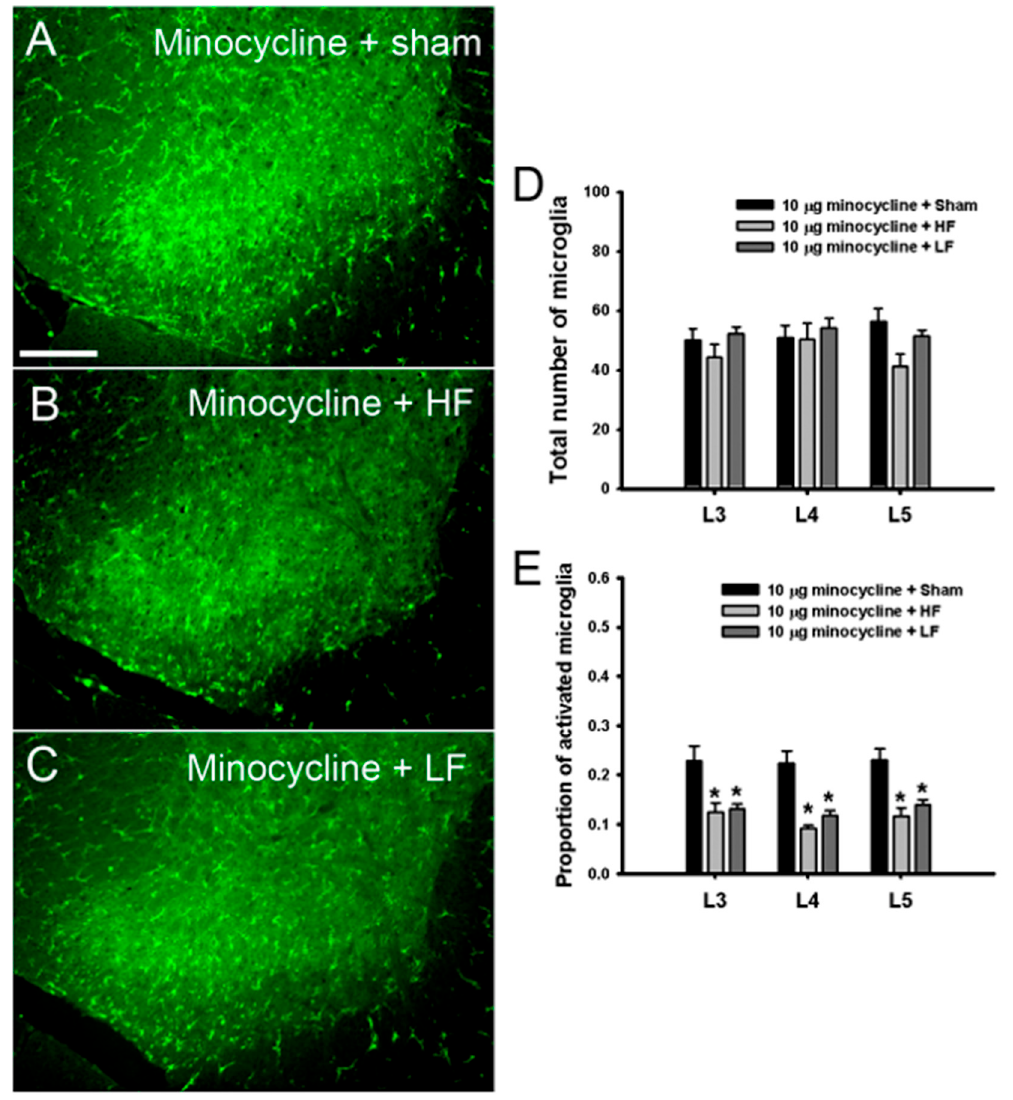
Figure 6. Changes in the expression of spinal microglia due to transcutaneous electric nerve stimulation (TENS) with minocycline (10 μ g) in TENS-tolerant rats ( A ) The expression of activated microglia was exhibited after sham TENS with minocycline. High-frequency (HF) TENS with minocycline ( B ) and low-frequency (LF) TENS with minocycline ( C ) changed the expression of microglia from the activated state to the resting state. ( D ) HF and LF TENS with minocycline treatments did not significantly change the total number of microglia expressed in the spinal segments compared with sham TENS with minocycline. ( E ) Compared with sham TENS with minocycline, both HF and LF TENS with minocycline treatment significantly decreased the proportion of activated microglia in the L3, L4, and L5 spinal segments. Asterisks (*) indicate values significantly different from that in the sham TENS with minocycline group. Scale bar: ( A – C ) 200 μ m.